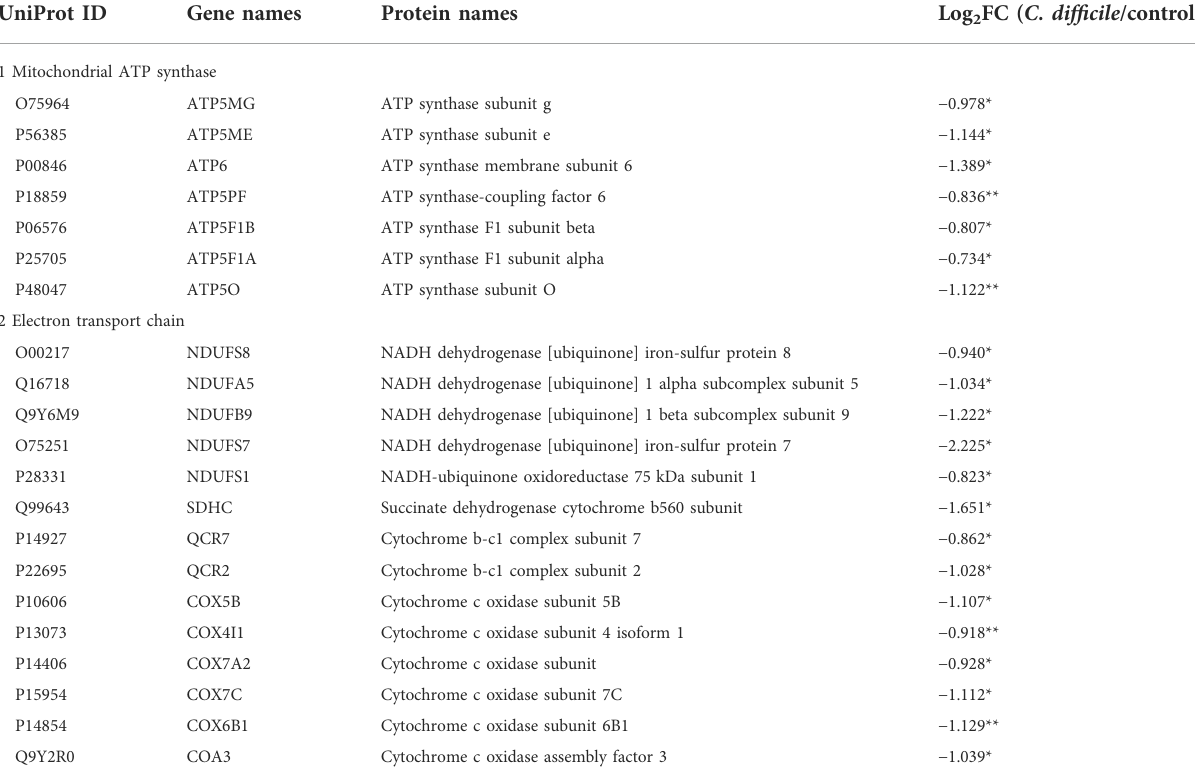
TABLE 1 List of identi fi ed proteins involved in the mitochondrial electron transfer chain. Proteomic analysis was performed in triplicate. UniProt